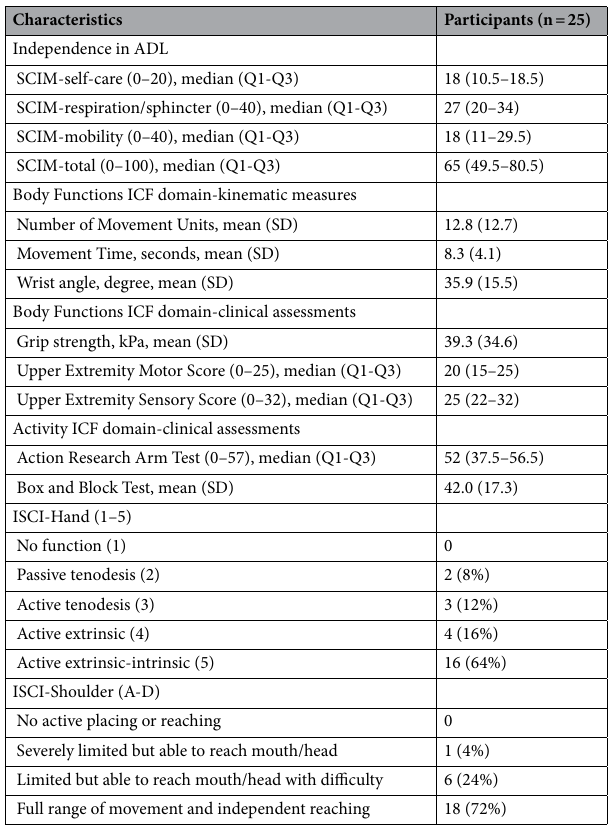
Table 2. Independence in Activities of Daily Living (ADL) and upper extremity assessments. ICF International Classification of Functioning, Disability and Health, ISCI International Spinal Cord Injury Upper Extremity Basic Data Set Form, ISCI-Hand basic Hand variable of the ISCI, ISCI-Shoulder Shoulder variable of the ISCI, SCIM Spinal Cord Independence Measure.